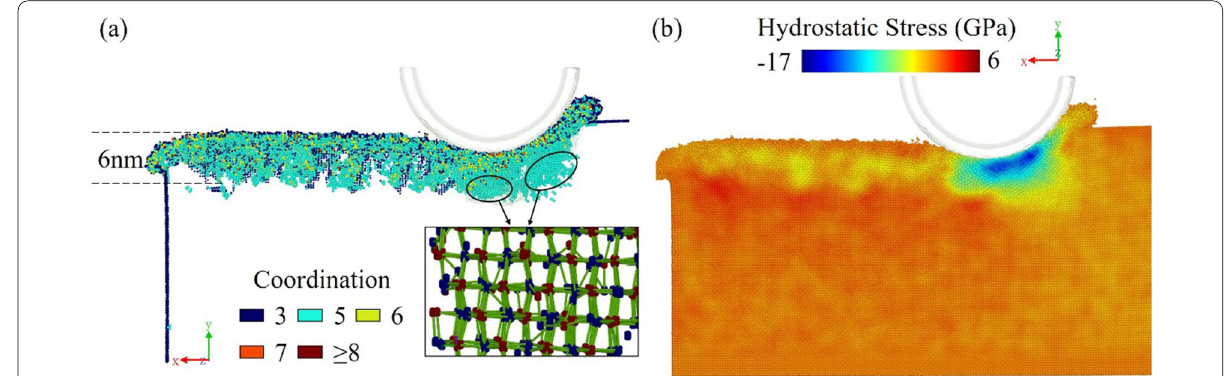
Fig. 9 Distribution of a high coordination atoms and five-coordination structure and b hydrostatic stress distribution